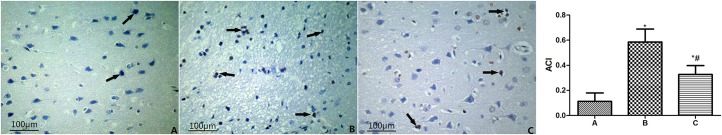
Apoptosis in cortex of rats, TUNEL×400.A. Control group; B. Model group; C. Treatment group; →. Apoptotic cells * P<0.05, compared with control group; #P<0.05, compared with model group